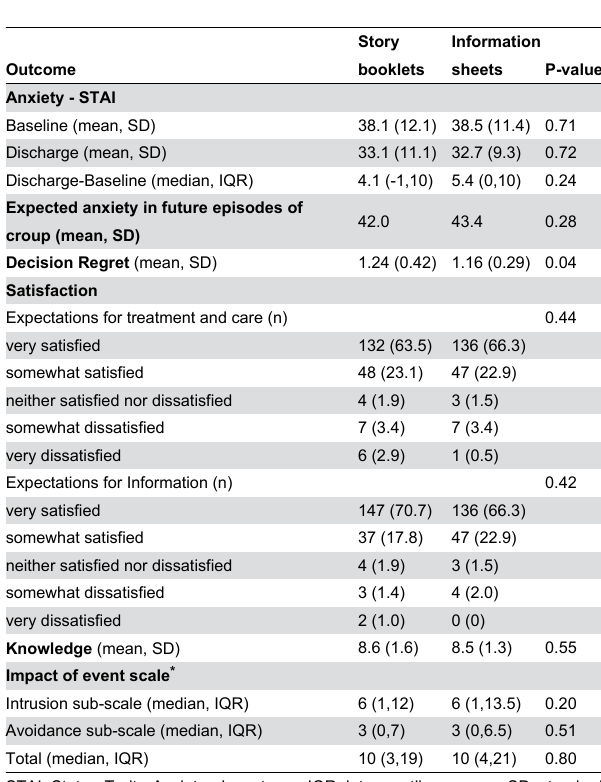
Table 5. Comparison of primary and secondary